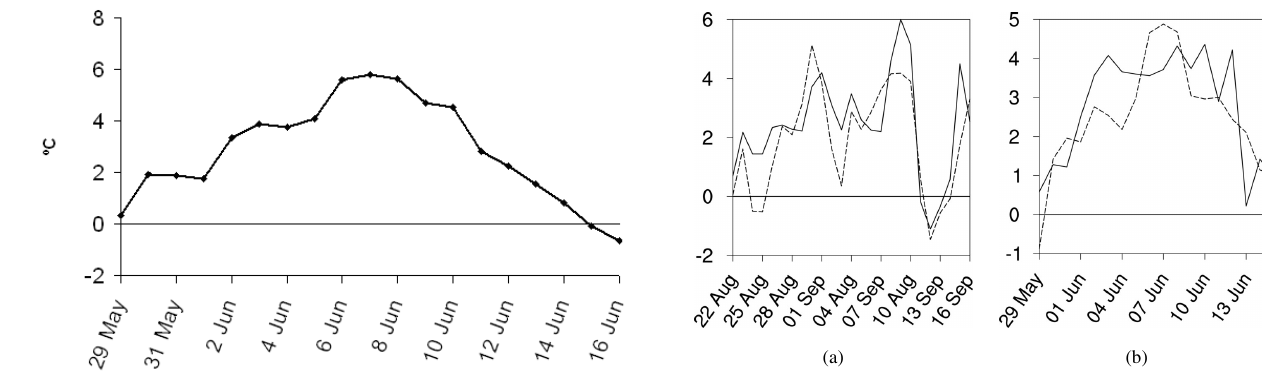
Fig. 4 – Evolution of temperature anomaly for (a) 20 Aug through 16 Sep 1999, and (b) 20 May through 21 Jun 2002 (see Table 1). Continuous line: obtained from surface observations in the target area. Broken line: obtained from NCEP reanalysis values in the grid boxes around the surface stations. WDS cases 29 and 32 (Table 1) are contained in the periods shown in panels a and b, respectively.